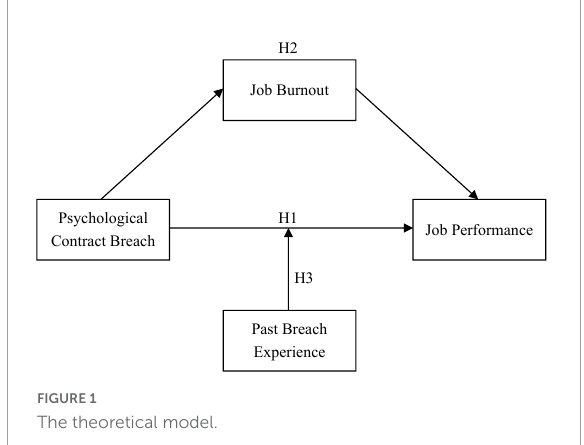
FIGURE1 The theoretical